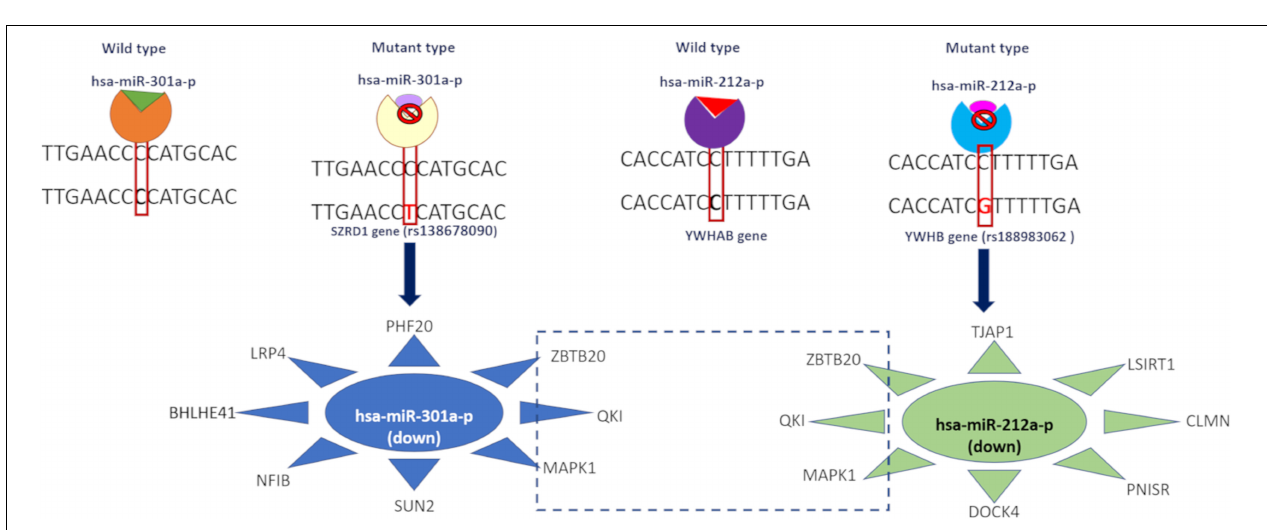
FIGURE 3 | Effect of 3 (cid:48) UTR variants in miRNA binding and downstream gene expression.